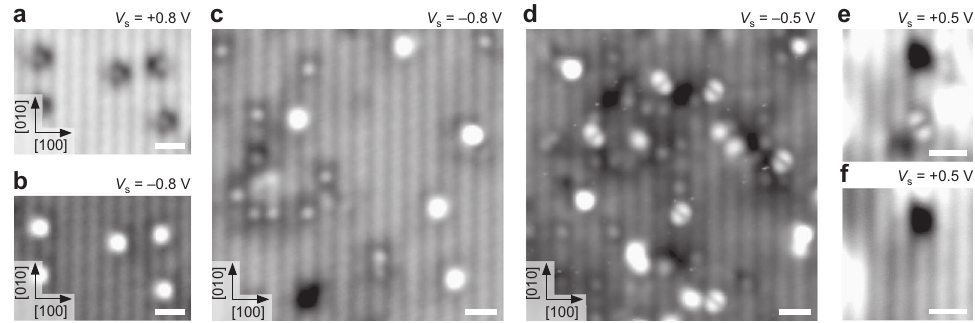
Fig. 8 Oxygen vacancies on cleaved Ca 3 Ru 2 O 7 . a Empty and b fi lled-states STM image of Ca 3 Ru 2 O 7 after irradiation with 1 keV electrons at 105 K. In empty states, the oxygen vacancy ( V O ) appears as a small, bright dot on the dark substrate line with a one-sided, dark patch extending into the bright substrate line. In fi lled states, the V O appears as a large, bright dot on the dark substrate line. c Filled-states STM image after exposure to 0.05 L water. d Different area than in panel c and after annealing to room temperature for 50 min. The bright , double-lobed features are attributed to neighboring surface hydroxyls, formed by the dissociation of water that fi lled the V O . e Small-area STM image of a double-lobed feature next to unidenti fi ed adsorbates. f Same area as in panel e , but after scanning the area with a bias of +4.5 V. The double-lobed feature has desorbed and at its former location the pristine surface is left behind. STM parameters: T sample = 78 K, I tunnel = 0.1 nA, for V sample see fi gures; fast scan direction is 16° a – d and 18° e – f anticlockwise from horizontal. All scale bars correspond to fi rst water has adsorbed and dissociated. In one case the (OH) ads is next to the unoccupied site, in the other case the O surf H.